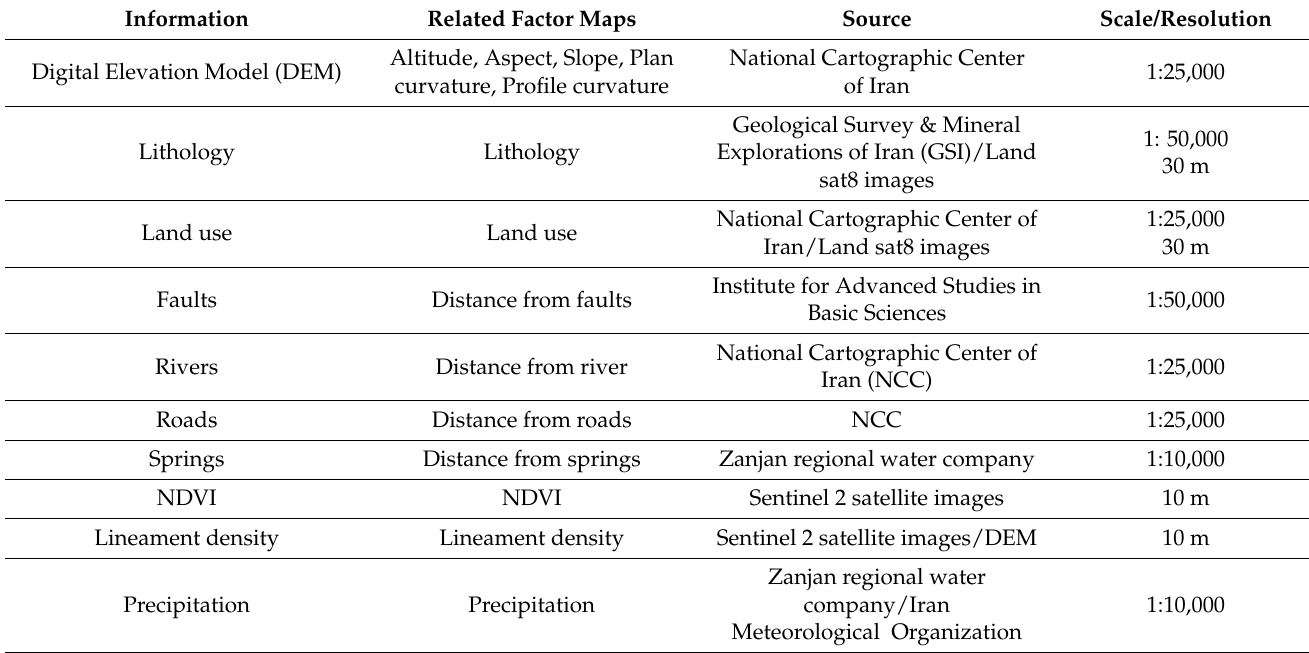
Table 1. Employed information and their sources in the current research.